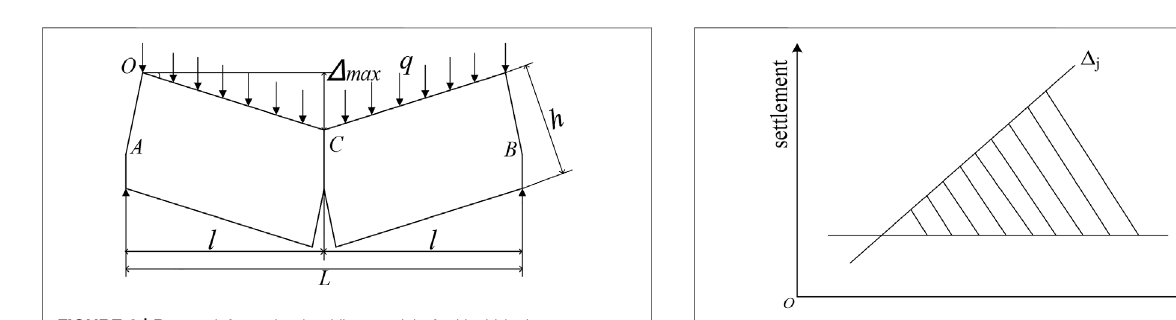
FIGURE 3 | Rotary deformation buckling model of critical blocks. The 3# coal seam is 3.5 – 14 m thick, with an average of 7.0 m. After advancing from the open – off cut by 500 m, the coal seam thickness increases gradually from 3 m to 14 m. The contour line